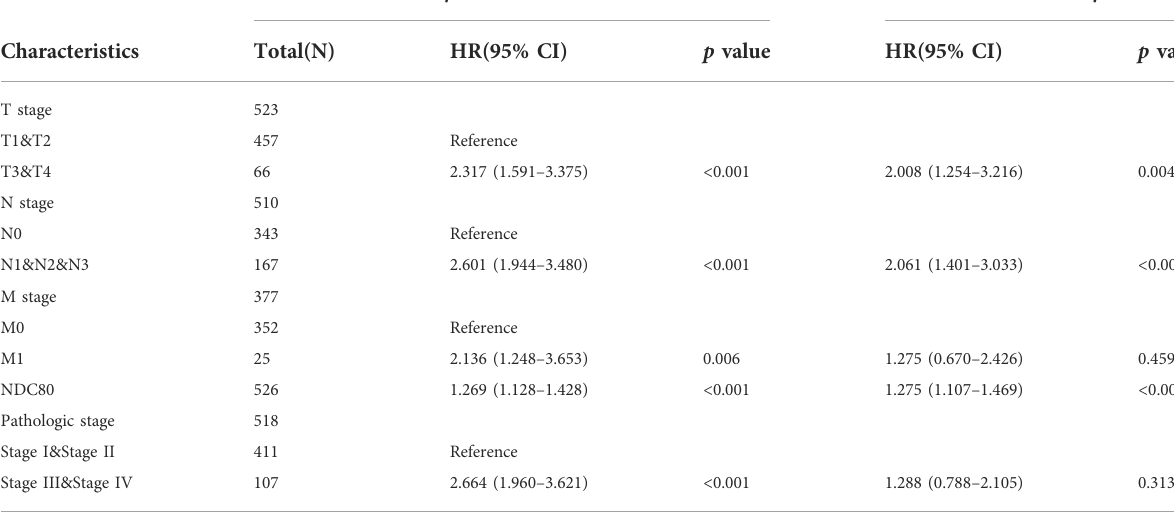
TABLE 1 The univariate and multivariate Cox regression analysis and clinical features of